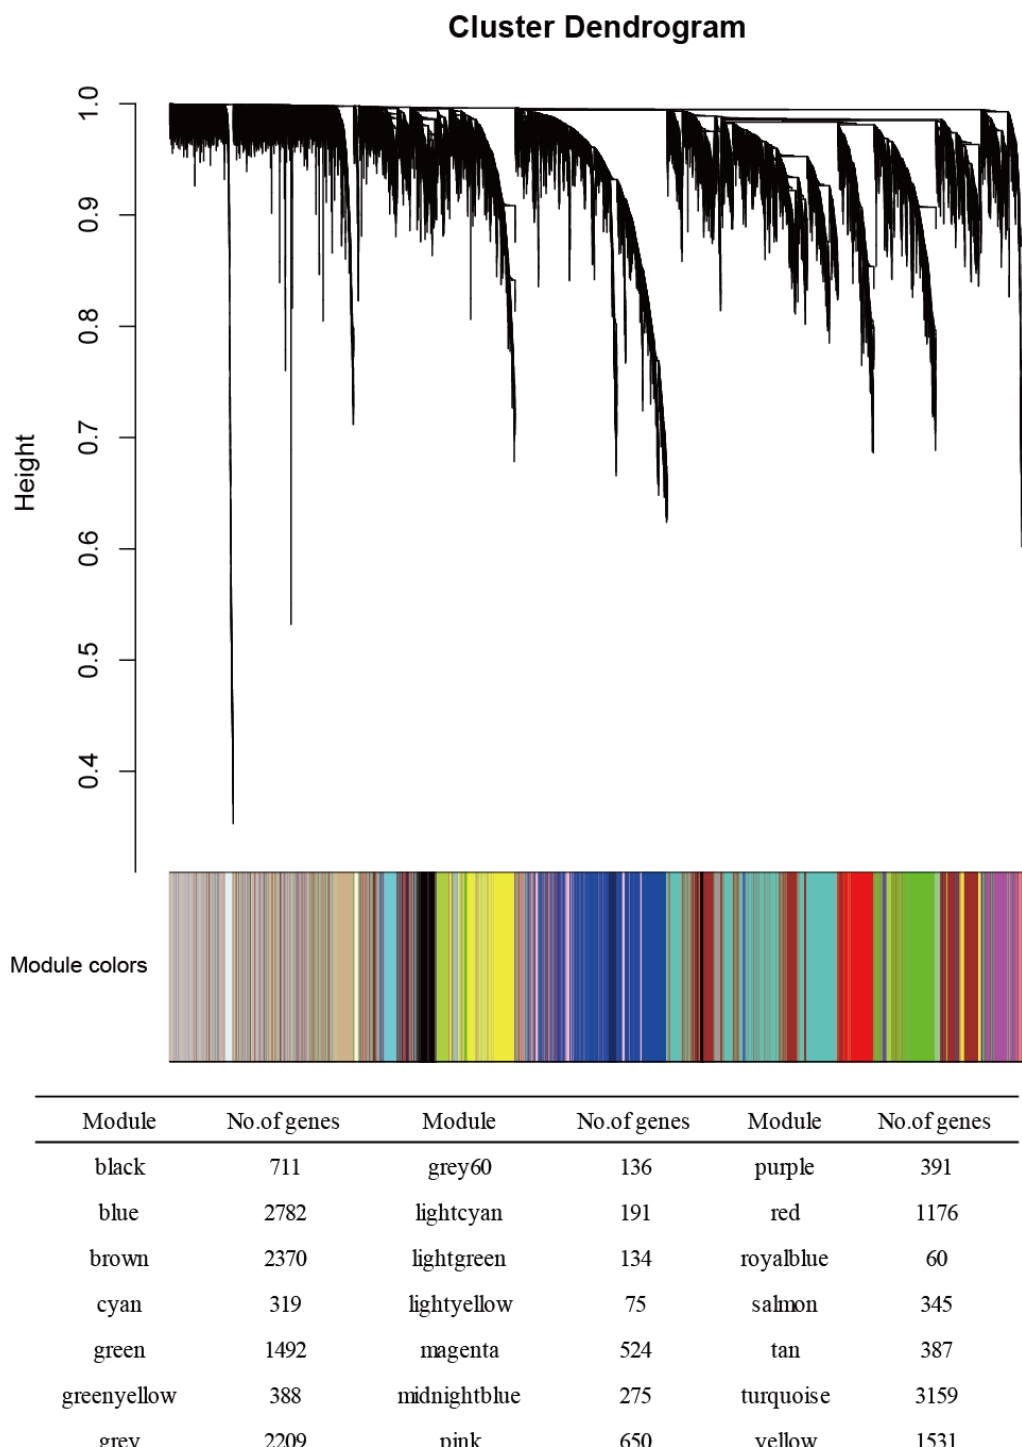
Figure 1. The results of the weighted gene co-expression network analysis (WGCNA) of the tran- scriptome in the normotensive and PE groups. In the clustering dendrogram with genes, the module membership is represented by colors. The numbers of genes in each module are also shown. Twenty-one modules were identified.